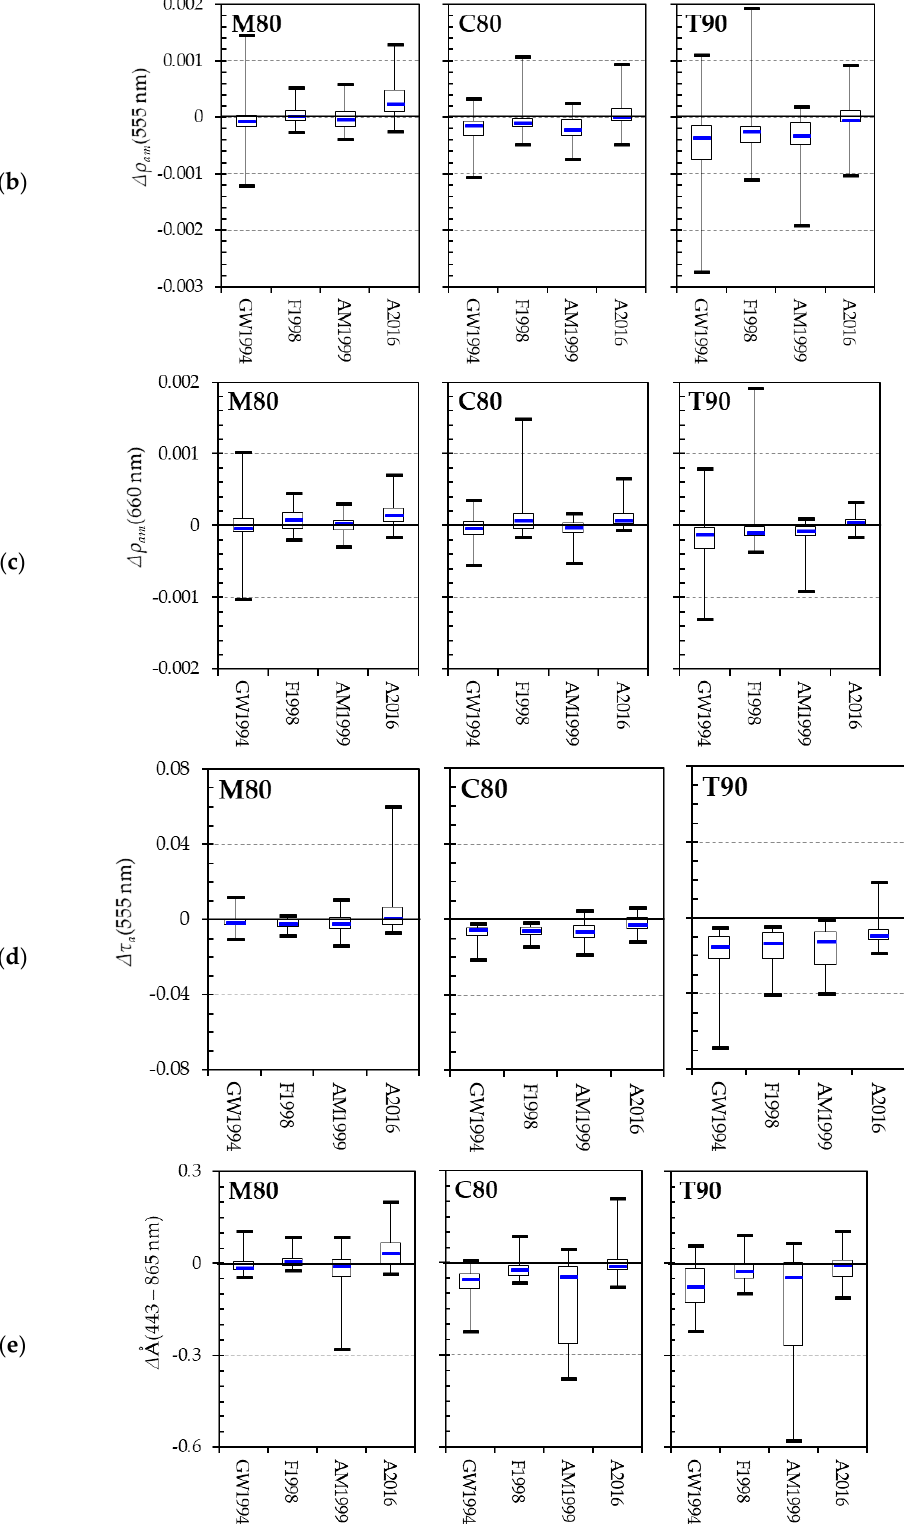
Figure 1. Errors in aerosol retrieval for the four schemes, presented as box-and-whisker plots. Aerosol reflectance differences by scheme for ( a ) the blue band (443 nm); ( b ) the green band (555 nm); and ( c ) the red band (660 nm); ( d ) aerosol optical thickness difference by scheme for the green band; and ( e ) aerosol Ångström exponent for 443 nm relative to 865 nm.